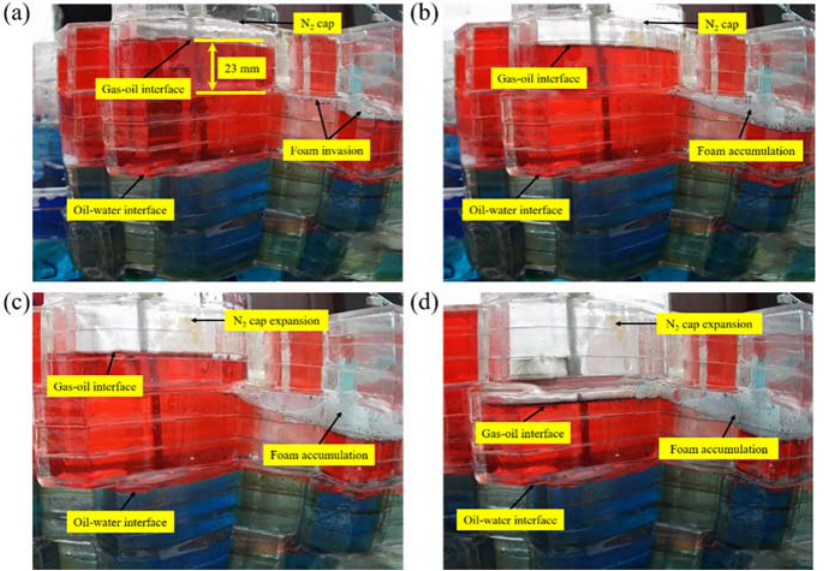
Figure 8. Mobilization of residual attic oil in the fracture–vuggy unit controlled by T401: ( a ) residual attic oil after water-driven, ( b ) Foam accumulation, ( c , d ) Decrease of gas-oil interface. Moreover, the position of GOI around well T401 with time is depicted in Figure 9. The slope of this graph represents the decline rate of GOI height. It shows that the GOI height in the vug top of the fracture–vuggy unit controlled by T401 decreases at a constant rate (0.018 mm/s). The result is different from the results obtained from the OWI height decline trends (Figure 6). The GOI height decline rate (0.018 mm/s) is lower than that of the OWI (steep stage, 0.028 mm/s) due to the different distances between their fracture–vuggy structures and the injection well TK467. The closer the distance, the greater the downward driven force, resulting in a fast decline rate [29,30]. The OWI decline rate (gentle stage, 0.008 mm/s) is lower than that of the GOI (0.018 mm/s), which results from the different connectivity between their fracture–vuggy structures and around structures. The vug, which locates at the top of the fracture–vuggy unit, has poor connectivity. Therefore, the accumulated N 2 and foam are less likely to spread to other fractures and vugs. On the contrary, the accumulated N 2 and foam in an excellent connectivity vug can migrate into other fractures and vugs, causing a lower OWI height decline rate.